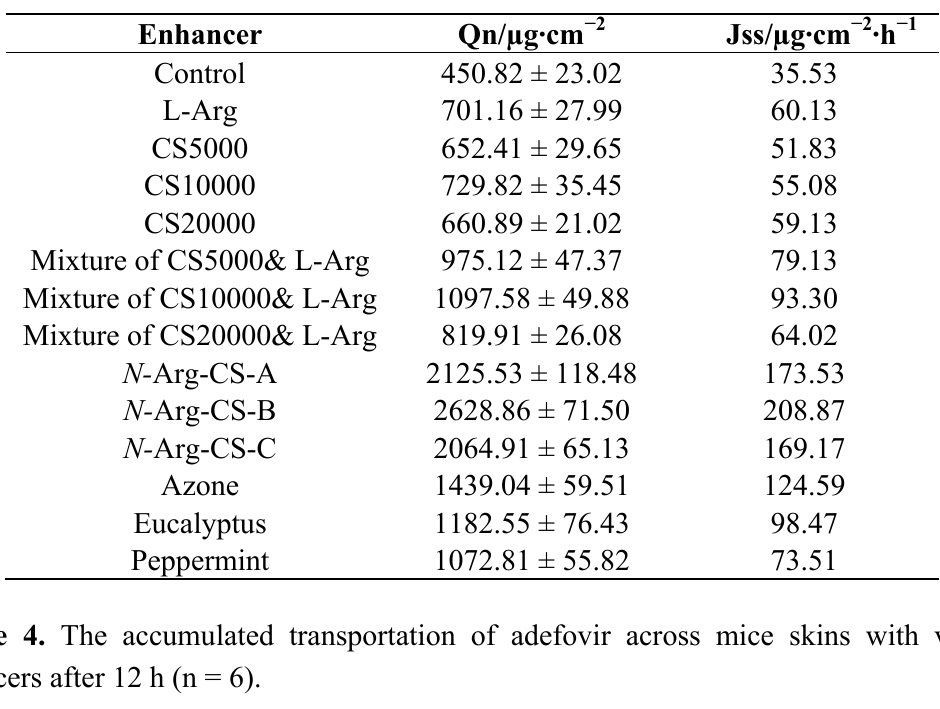
Table 3. The accumulated transportation of adefovir across mice skins with various enhancers after 12 h (n = 6).